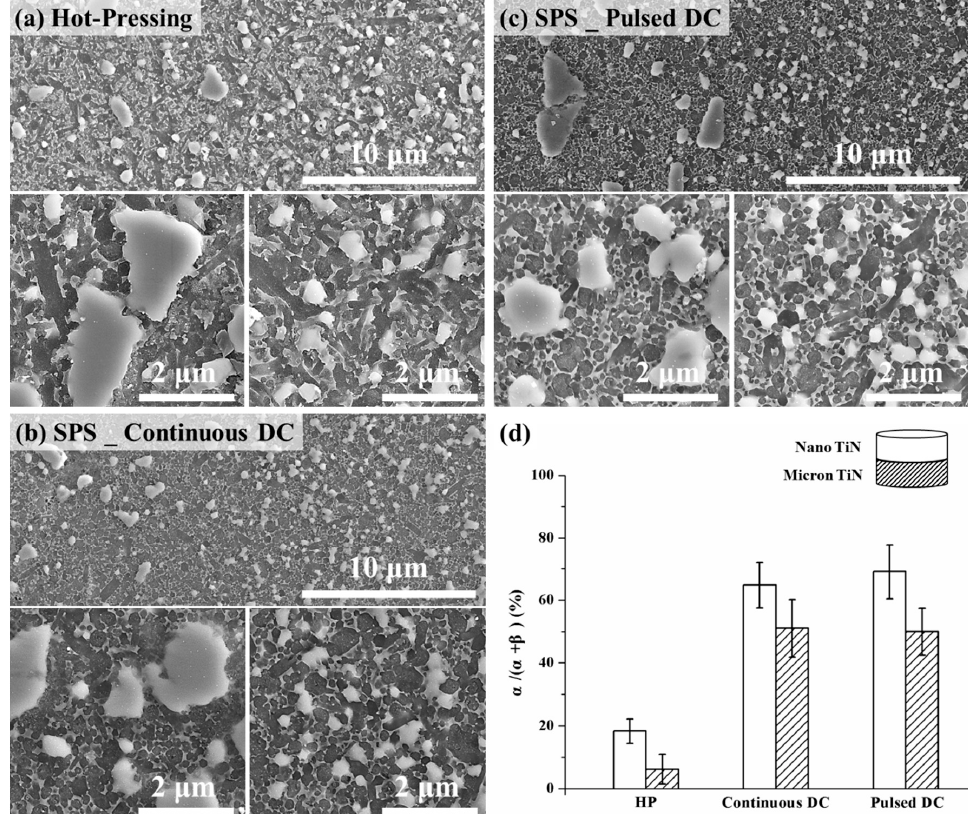
Figure 7. Low (upper side, including the layer interface) and high (underside) magnification cross-section views of the double-layered Si 3 N 4 -10 vol % TiN composites, prepared at 1700 °C for 5 min with nano- and micro-TiN, by using ( a ) hot-pressing, ( b ) spark plasma sintering (SPS) continuous mode, and ( c ) SPS pulsed mode; and ( d ) the α -Si 3 N 4 fraction within each